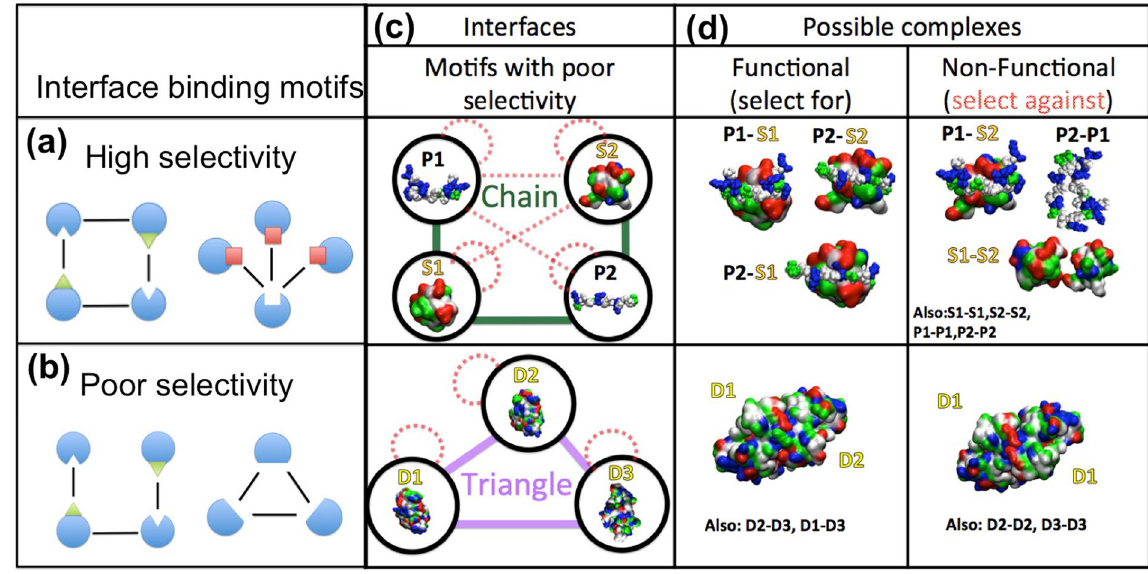
Figure 2. Motifs uncommon in the biological IINs due to poor interface binding selectivity. ( a ) IIN motifs that confer high selectivity. Binding partners may achieve structural and chemical complementarity with few constraints. ( b ) IIN motifs with poor selectivity. ( c , d ) For the motifs with poor selectivity, (chain and triangle motifs) functional interactions are indicated by solid lines and interfaces should be optimized to stably form these complexes. However, the possible non-functional interactions between the interfaces (red dashed lines) are difficult to simultaneously optimize for much weaker binding because they share structural and chemical complementarity to the functional complexes. For the chain motif, illustrated with SH3 and PRD domains, the top interaction (S2-P1) is hard to prevent. For the triangle motif, illustrated with kinase domain interfaces that form side-by-side dimers (B-raf, Raf-1 36 , Ksr1) the homo-dimer binding interaction is hard to prevent. In fact, these kinase interfaces really do form both hetero- and homo-dimers, so the biological system has no challenge for optimizing selectivity. Binding surfaces are colored by residue as non-polar (white), polar (green), acidic (red), and basic (blue). Example structures from 2RPN, 2LCS, 1UWH, 3OMV.pdb. Truly non-functional interactions (i.e. PRD-PRD) are just illustrations.